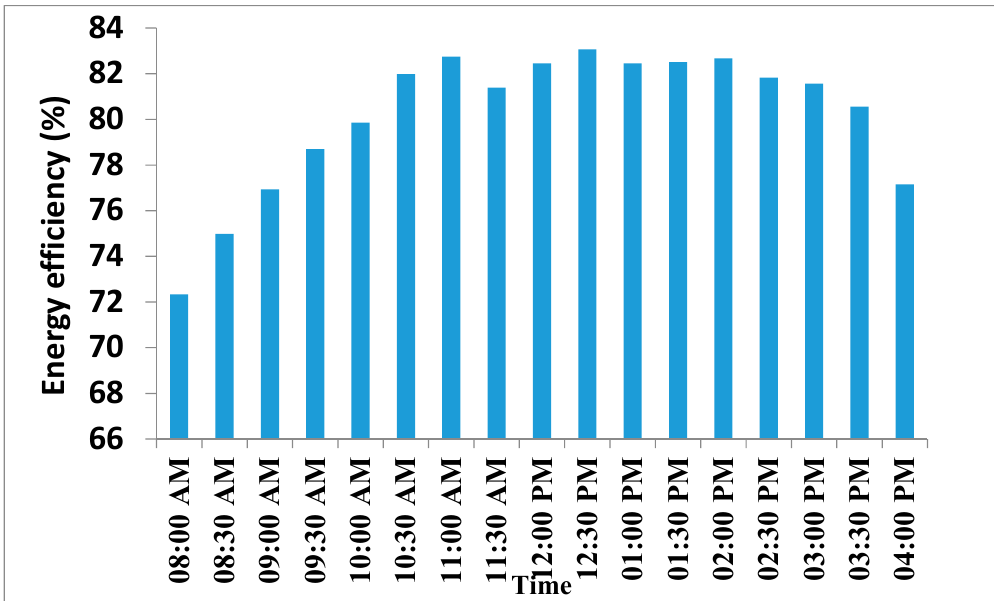
Figure 7. Variation of energy efficiency of PVT system with time.